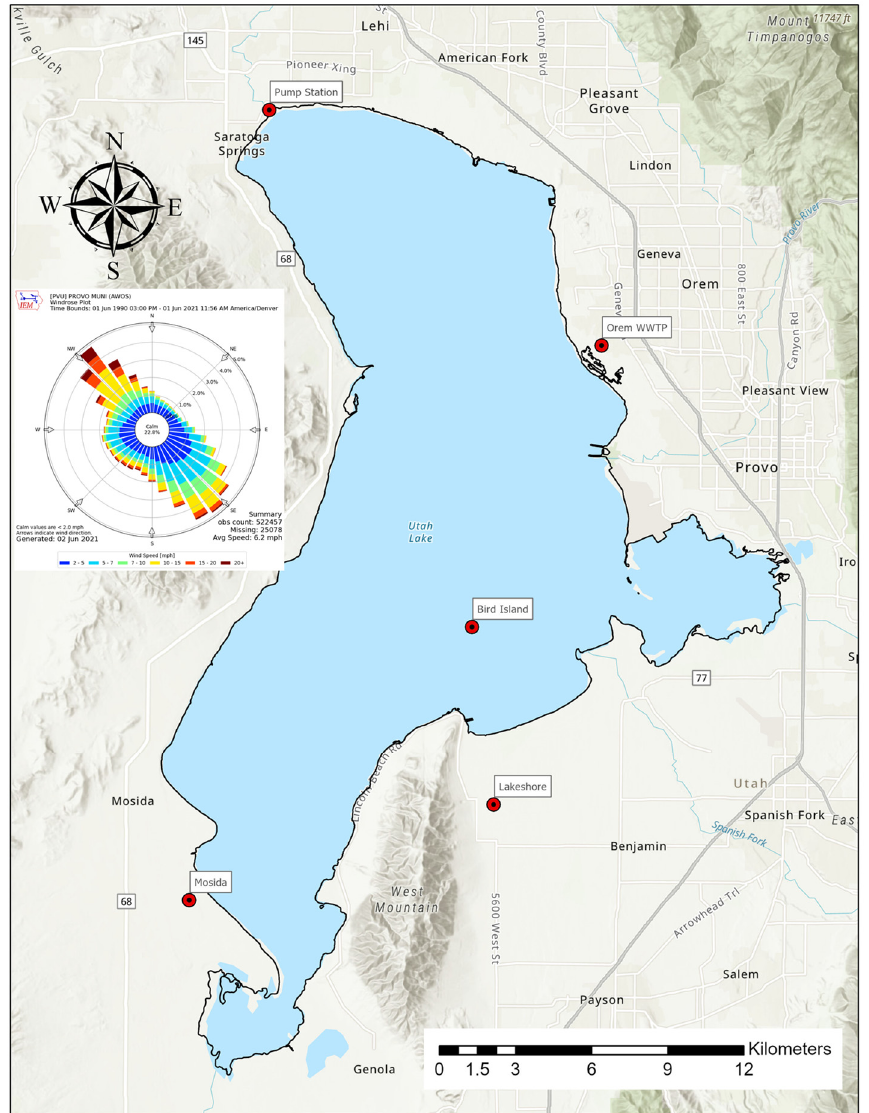
Figure 1. AD sampling sites around and in Utah Lake and a wind rose showing the wind direction at the Provo Municipal Airport based on data from June 1990 to June 2021, generated by Iowa Environmental Mesonet (IEM), Iowa State University generated 2 June 2021 (https://mesonet.agron.iastate.edu, accessed 2 June